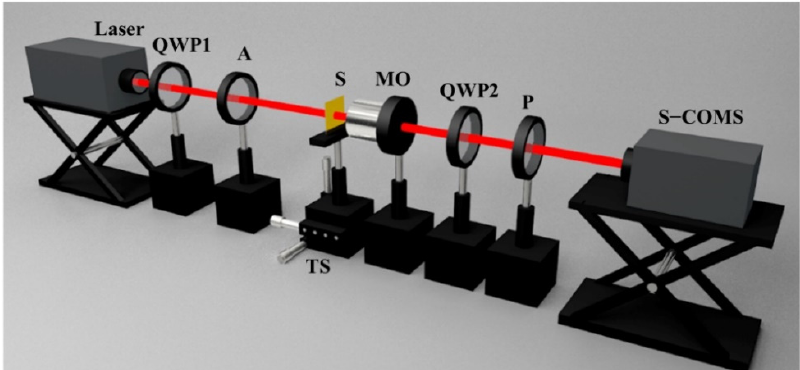
Figure 6. Schematic illustration of the experimental setup. QWP1 and QWP2 represent quarter-wave plates, A is attenuator, S stands for sample, microscope objective lens is denoted by MO, and P is Glan–Thompson polarizer. Laser is He–Ne with an emission wavelength of 632.8 nm, and the S-CMOS camera model is Zyla 5.5.